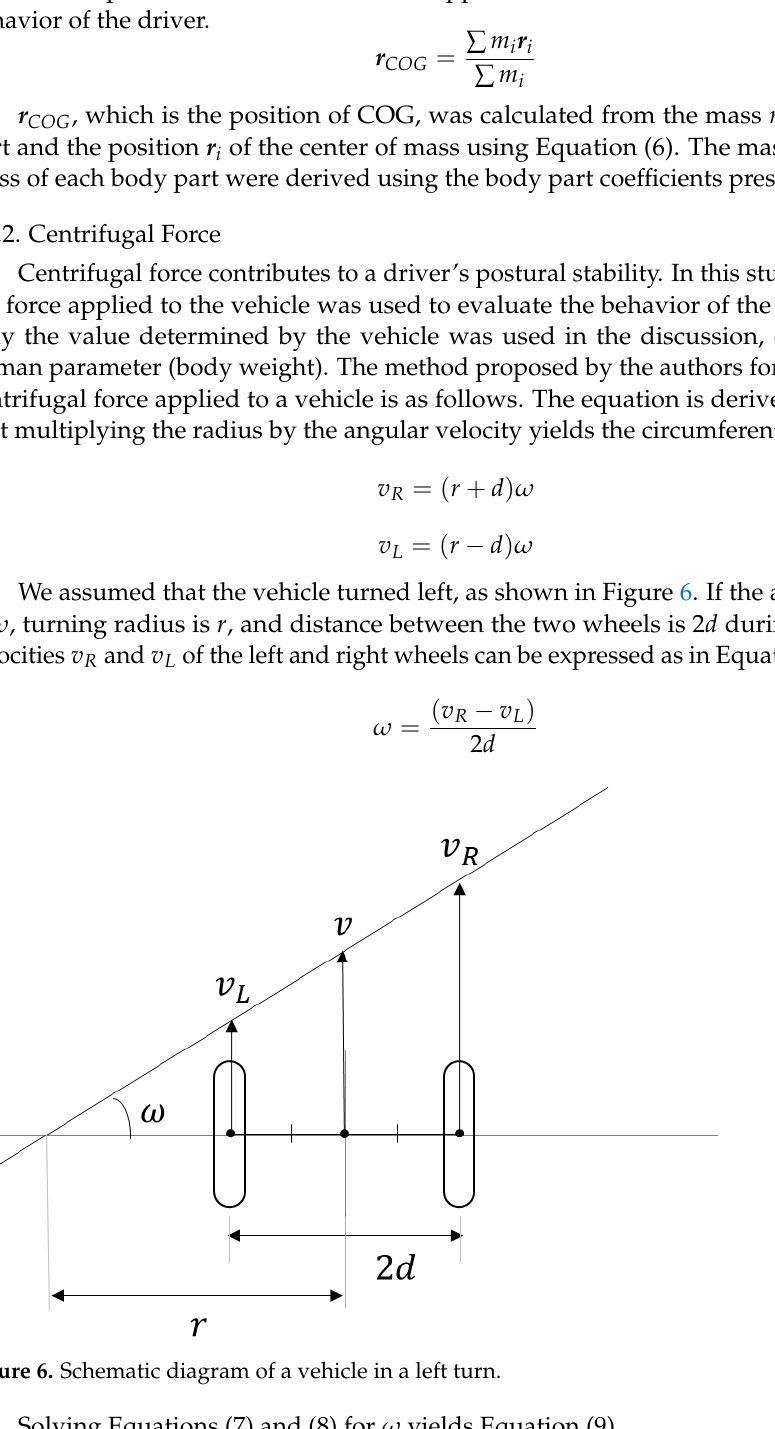
Table 3. Classification of correlation strength.